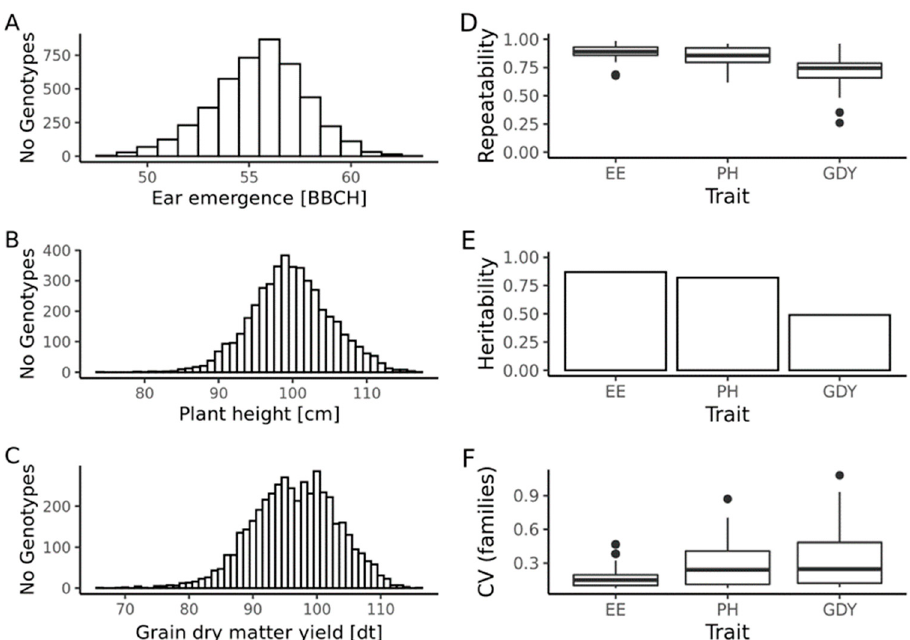
Figure 1. Distribution of phenotypic records ( A – C ), distribution of repeatabilities at test environments ( D ), heritabilities ( E ), and coefficients of variation (CV) of the families ( F ) for the traits ear emergence (EE), plant height (PH) and grain yield (GDY).